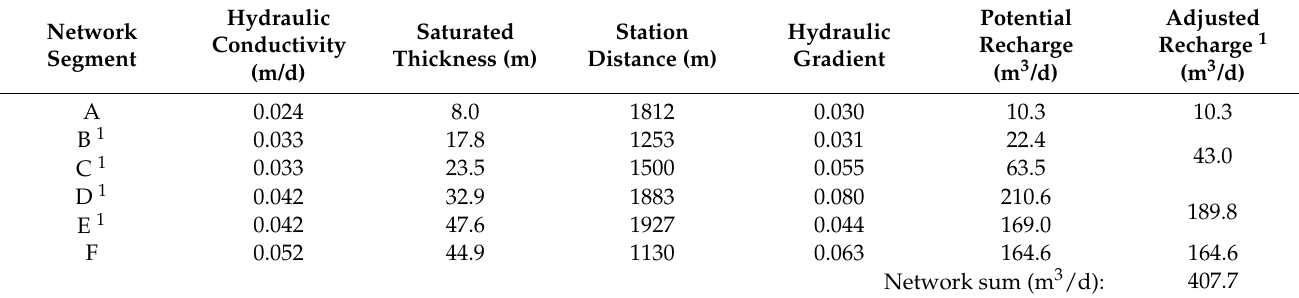
Table 4. Example of recharge calculations at each network segment and total recharge across the network for 1 October 2020. Overlapping segments were averaged for an adjusted recharge value.